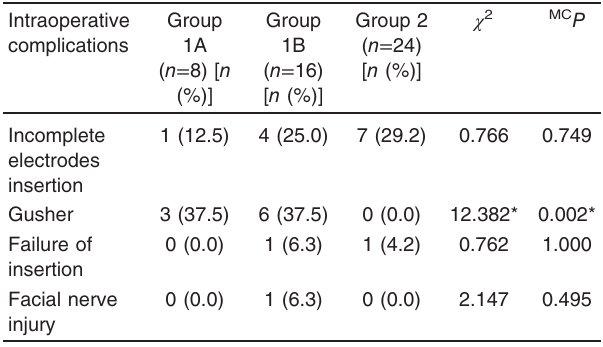
χ 2 , χ 2 -test for comparing among the three groups; MC P , P value for Monte Carlo for χ 2 -test for comparing between the three